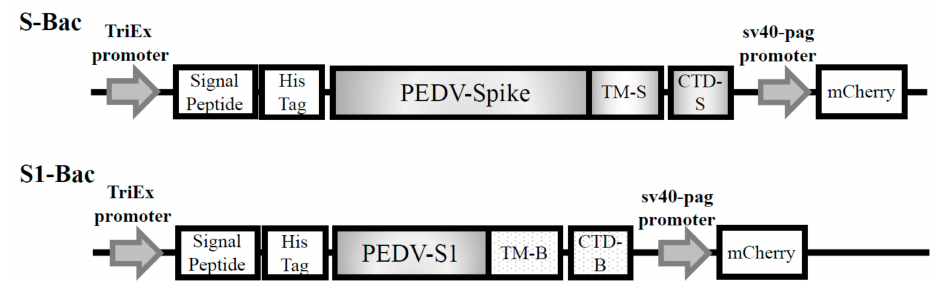
Figure 1. The organization of the expression cassette and the construction maps of the plasmids, pTriEx-S and pTriEx-S1, for generation of membrane-anchored recombinant baculovirus, S-Bac and S1-Bac. The full-length spike (S) and S1 genes are driven by the TriEx promoter, followed by the GP64 signal protein and 6xHis-tag. The pTriEx-S contains the codon optimized full-length S gene derived from the Taiwan G2b PEDV-PT strain with its original PEDV S transmembrane domain (TM-S) and the PEDV S cytoplasmic domain (CTD-S) for membrane anchoring. The pTriEx-S1 has the codon optimized S1 gene associated with GP64 transmembrane domain (TM-B) and the GP64 cytoplasmic domain (CTD-B) for membrane anchoring. Both constructs were also inserted with an mCherry fluorescent protein gene driven by the SV40-pag promoter as a